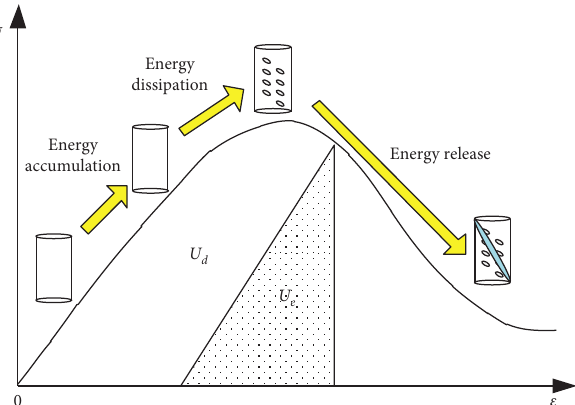
Figure 2: Relationship between energy change and stress-strain state of unit volume coal element.